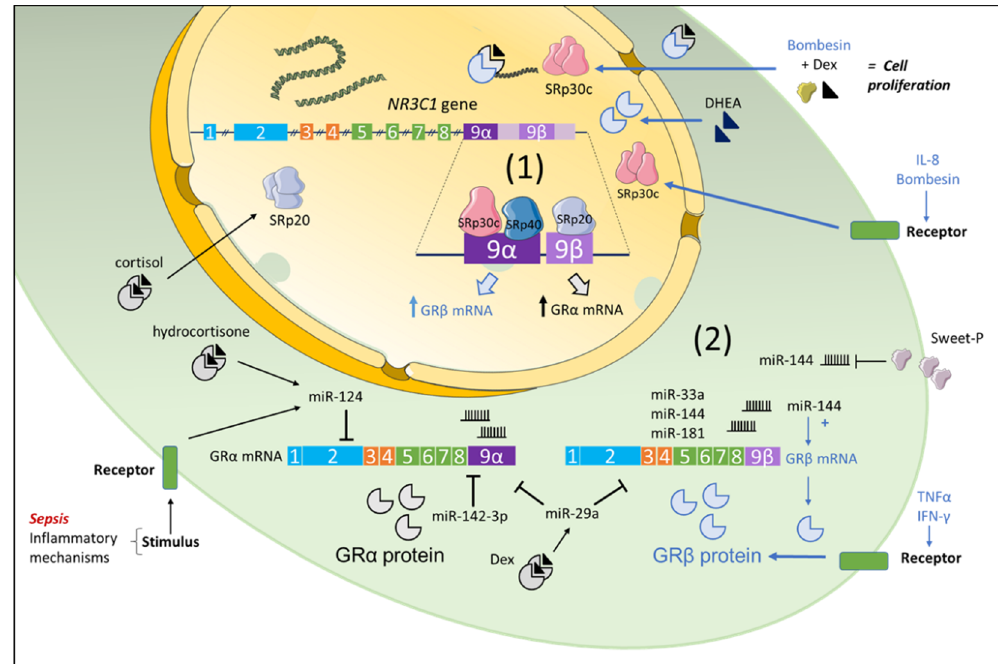
Figure 1. General overview of the transcriptional induction of GR β . ( 1 ) Regulation of GR β expression by serine–arginine proteins (SRps): While exon 9 α is predicted to have more binding sites for SRp30c and SRp40, exon 9 β possess more binding sites for SRp20. Elevated activity of SRp30c and SRp40 on exon 9 α would increase exon 9 β splicing and thereby the generation of GR β mRNA. Alternatively, more binding sites for SRp20 on exon 9 β would increase exon 9 α and thereby the GR α mRNA splicing. Experimental evidence demonstrates that mediators, such as IL-8 in neutrophils or bombesin in PC3 cells, increase the levels of SRp30c, which enhances the alternative splicing of GR pre-mRNA to generate GR β mRNA. Treatment with dexamethasone in the presence of bombesin resulted in increased cell number as compared to dexamethasone alone. Moreover, while dehydroepiandrosterone (DHEA) induced the upregulation of GR β by increasing the expression of SRp30c, cortisol enhanced SRp20 to promote GR α . Therefore, changes in SRps expression result in a differential GR α /GR β ratio. ( 2 ) Regulation of GR β expression by microRNAs (miRNAs): Emerging evidence suggests that miRNAs differentially target GR α or GR β transcripts. GR β expression is directly regulated by targeting miRNAs that specifically binds GR β or indirectly by miRNAs that downregulated GR α expression. While miR-33a and miR-181a/b/c/d were predicted to specifically bind the 3 (cid:48) UTR of human GR β (hGR β ), where miR-144 significantly upregulated the expression of GR β in bladder cancer cells, miR-124 and miR-142-3p specifically targeted GR α and augmented the expression of GR β in T cells. In contrast, dexamethasone induced miR-29a, which reduced both GR α and GR β in human and mouse adipose tissue. Inflammatory signals but also GC treatment promote the increase in miR-124 and miR-142-3p, activating a negative feedback loop that promotes GC resistance through imbalance of the GR α /GR β ratio. Targeting miR-144 with Sweet-P significantly reduced the expression of GR β mRNA in human bladder c